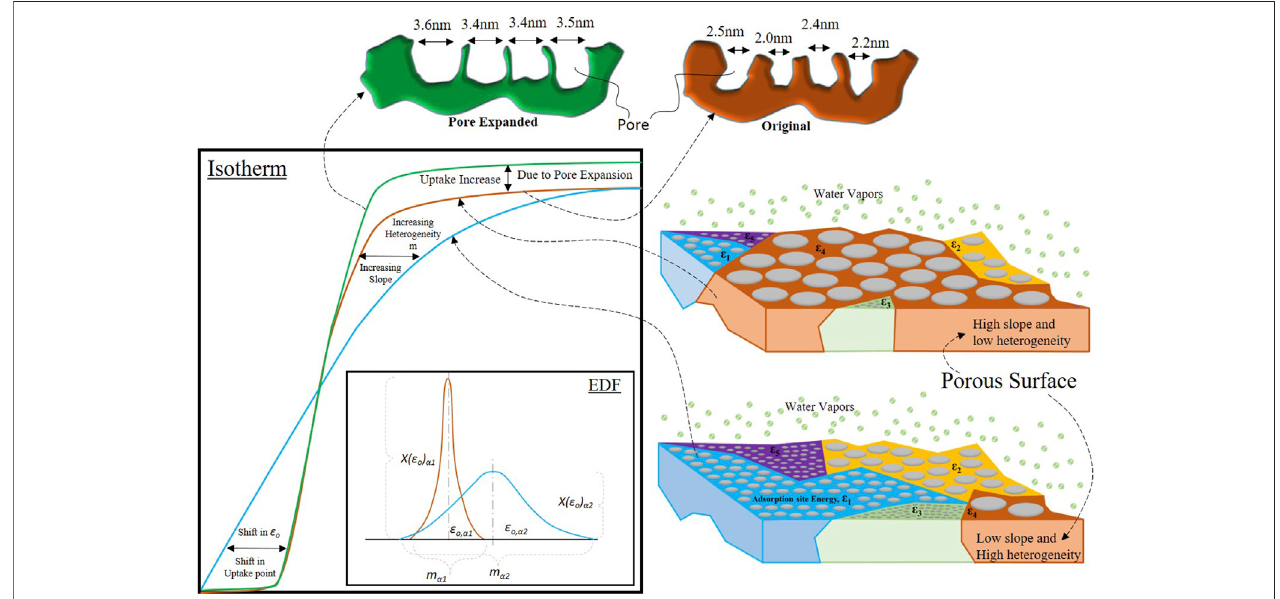
FIGURE 1 | Schematic diagram representing adsorption isotherm characteristics and its association with the porous adsorbent surface and energy distribution of these adsorption sites.